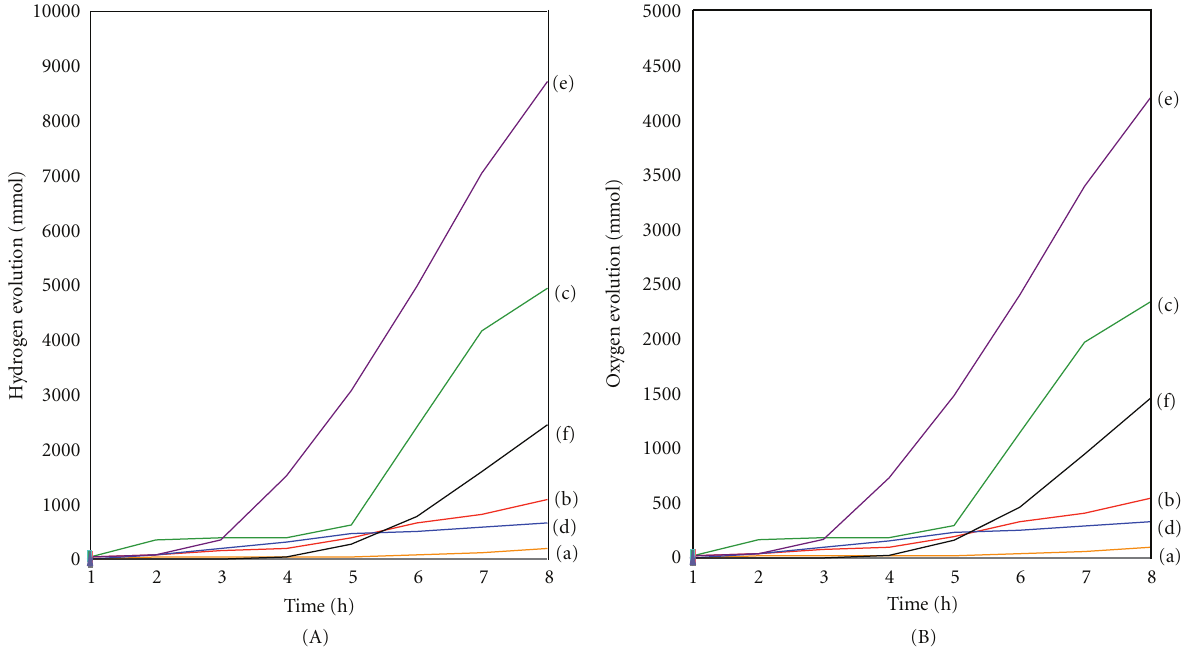
Figure 7: The evolution of H 2 from methanol/water decomposition over the six photocatalysts in a batch-type liquid photosystem. (A) accumulated amount of hydrogen gas and (B) accumulated amount of oxygen gas. (a) TiO 2 , (b) Cu(0.1)-Ti(0.9)O 2 , (c) Cu(0.07)- Ag(0.03)Ti(0.9)O 2 , (d) Cu(0.05)-Ag(0.05)Ti(0.9)O 2 , (e) Cu(0.03)-Ag(0.07)Ti(0.9)O 2 , and f) Ag(0.1)-Ti(0.9)O 2 .